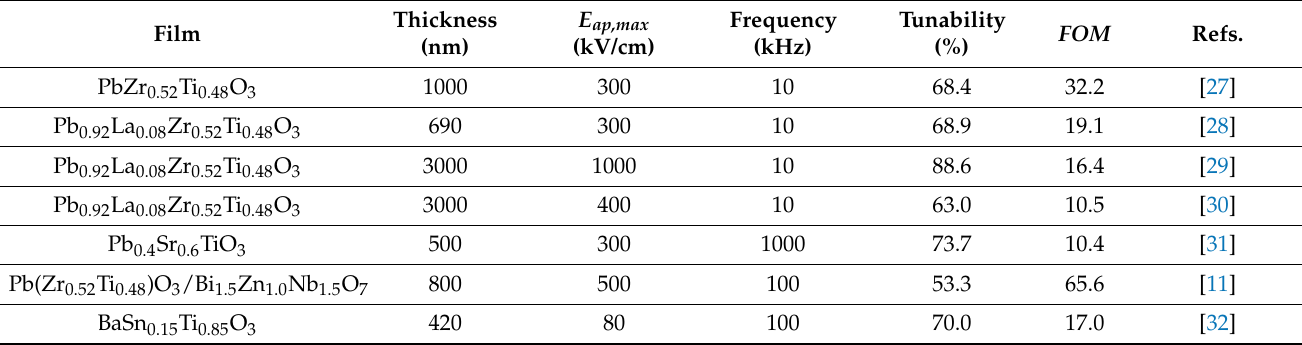
Table 1. Tunability and FOM of lead-based and lead-free